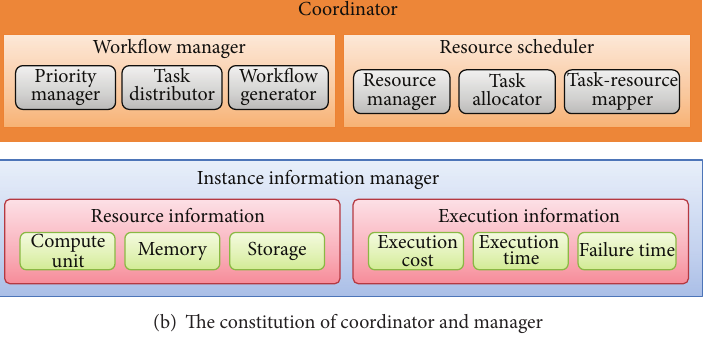
Figure 2: Workflow environment.